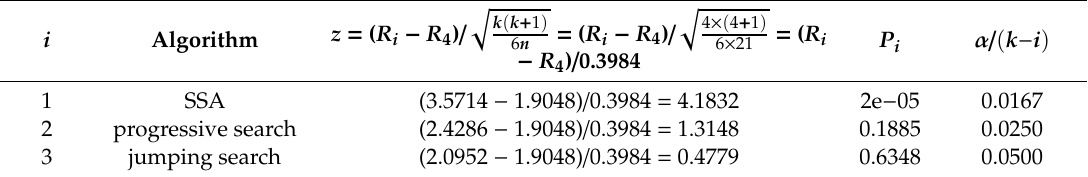
Table 7. The results of the Holm